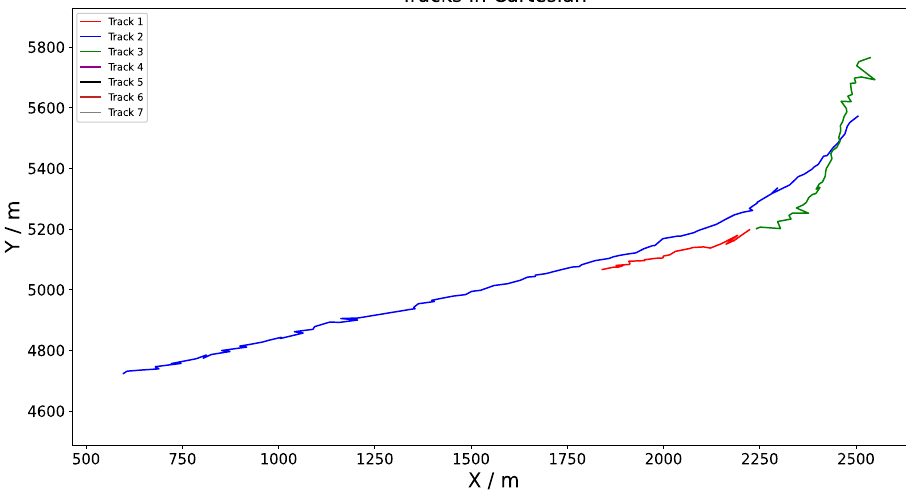
Figure 26. Multi-target tracking in the Cartesian coordinate system (CMKF-REMTT).